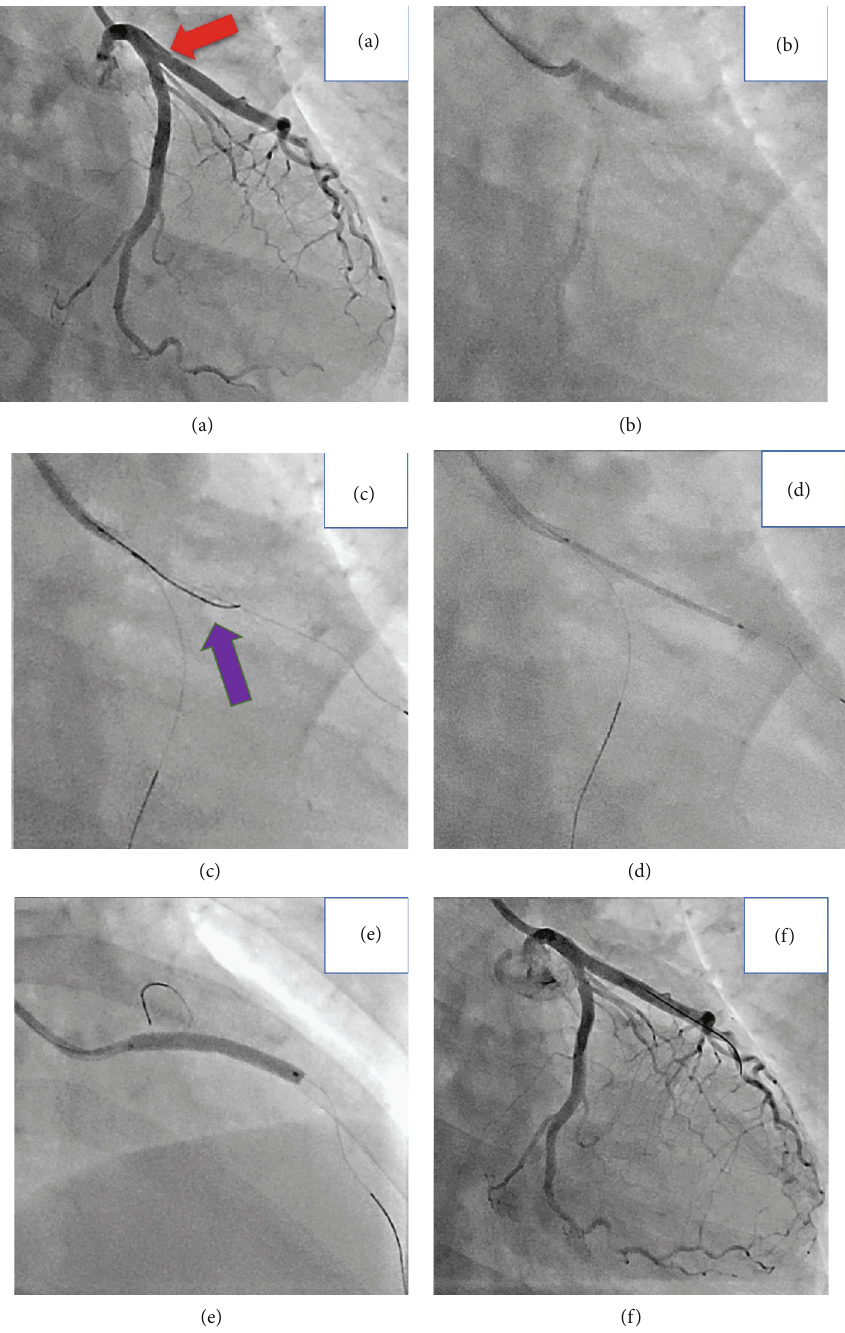
Figure 1: Coronary angiography and percutaneous coronary intervention. (a) Left coronary angiography (right anterior oblique caudal view) revealed a dissection at the proximal site of the LAD extending from the LMT, suggestive of type 1 spontaneous coronary artery dissection (red arrow). (b) Coronary blood fl ow of the LAD was impaired after coronary angiography. (c) The IVUS-guided rewiring technique was performed, and the third guide wire (purple arrow) was inserted from the true lumen of the LCX to the true lumen of the LAD by referring to the IVUS fi ndings of the dissected segment. (d and e) A drug-eluting stent was deployed to cover the dissected segment. (f) Final coronary angiography revealed acceptable results. LMT: left main trunk; LAD: left anterior descending artery; LCX: left circum fl ex artery; IVUS: intravascular